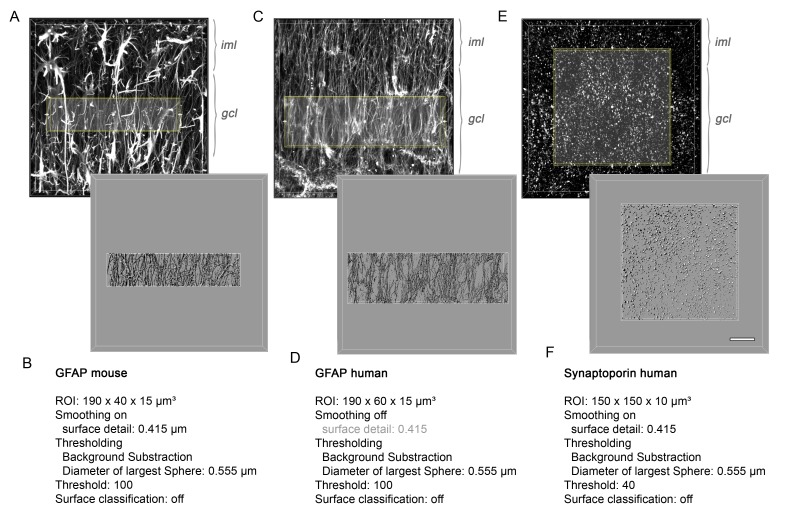
Imaris-based 3D-reconstruction.(A) Volume-rendered confocal z-stack of GFAP staining in mouse (C) human, and (E) Synaptoporin in human DG (upper panel). Corresponding surface reconstruction of immunolabeled profiles within a region-of-interest in the GCL (lower panel). gcl, granule cell layer; iml, inner molecular layer. (B, D, F) List of parameters used for Imaris-based surface reconstruction.